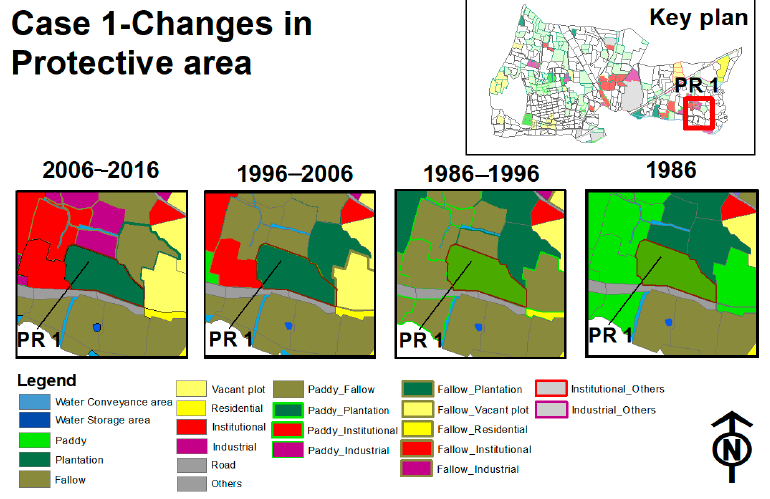
Figure A2. Trajectories of change: Case 1—protective area.